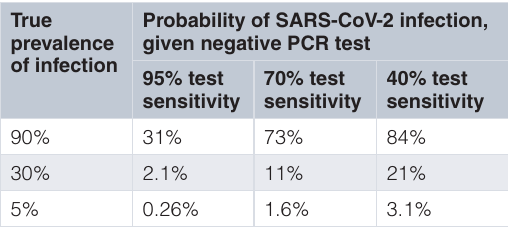
Table 1. Estimated probability of a false negative SARS-CoV-2 PCR test under various assumptions about the true prevalence of infection and the sensitivity of the test 24 . All estimates assume a test specificity of